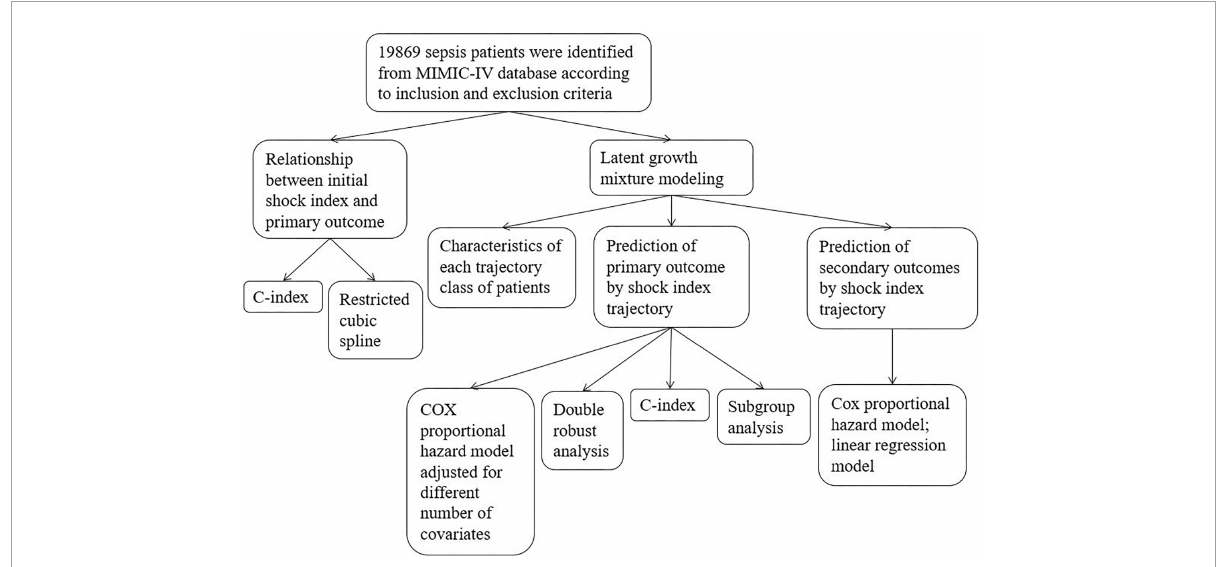
FIGURE1 Flow chart. Primary outcome was in-hospital death; secondary outcomes included in-ICU death, 28-day death, ventilation-free days in 28 days, and vasopressor-free days in 28